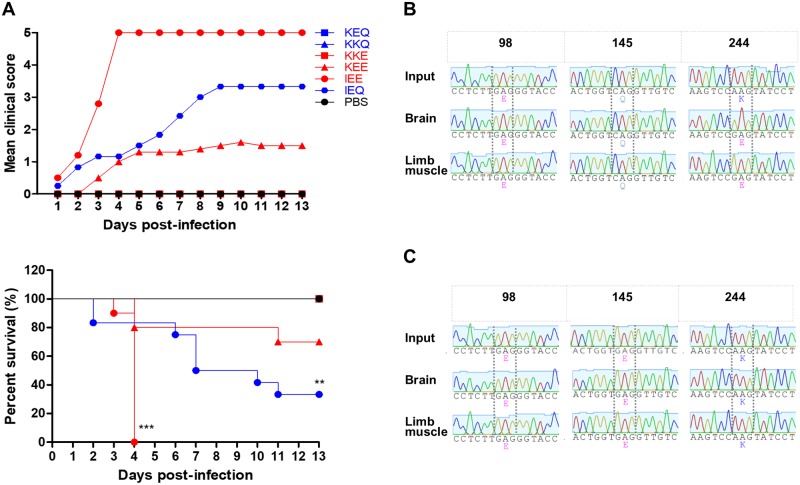
Clinical scores and survival rates of suckling mice infected with EV-A71 variants.One-day old suckling mice (n = 9–12) were inoculated with 1 × 105 PFU of different EV-A71 variants by i.p. injection. (A) A litter of mock-infected mice was used as a control group receiving PBS injection. The clinical scores and percentage of survival of the infected mice groups were monitored daily for 13 days. The severity of clinical symptoms was scored as follows: 0, healthy; 1, weak or less active; 2 hunched posture and lethargy; 3, one-limb paralysis; 4, two-limb paralysis; 5, moribund or dead. Significant differences compared to KEQ are labelled as * (P < 0.05) and ***P (< 0.001). KEQ, KKQ and KKE curves are identical to that of the mock-infected group. The representative VP1 sequence chromatograms of IEQ (B) and IEE (C) populations isolated from infected animal organs (n = 3) are shown, highlighting VP1-98, VP1-145 and VP1-244. The emergence of IEQ-244E virus isolated from brains and limbs of IEQ-infected moribund mice (n = 3) are shown.